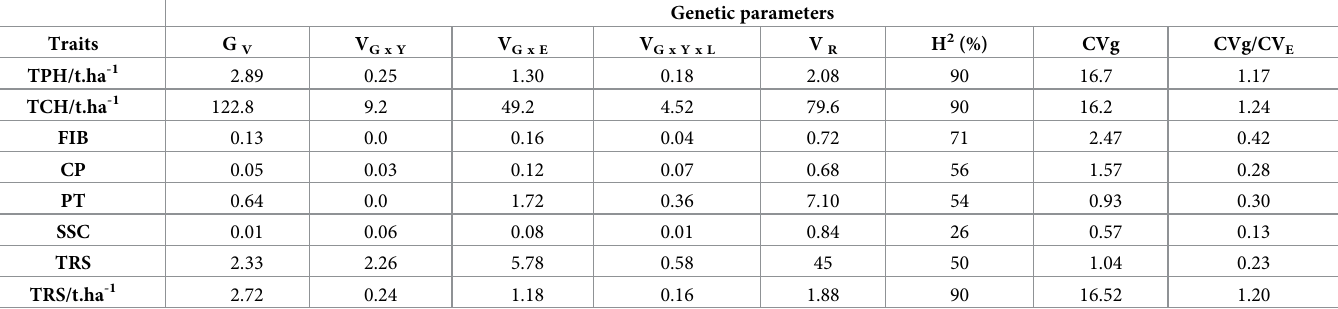
Table 5. Components of variance and genetic parameters of the traits of sugarcane genotypes evaluated over two consecutive years during the final phases of trials conducted in sugarcane microregions in the State of Pernambuco.